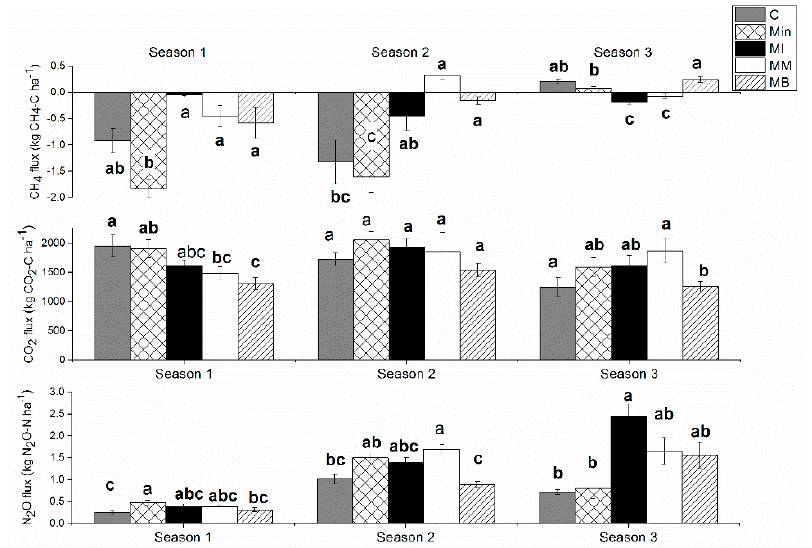
Figure 7. Cumulative CH 4 (CH 4 − C kg ha − 1 ), CO 2 (CO 2 − C kg ha − 1 ), and N 2 O (N 2 O − N kg ha − 1 ) with standard errors fluxes over the three growing seasons sampled from different plots with different fertilizer and manure/irrigation treatments. Bars with different letters indicate significant differences among the treatments (Duncan’s test 0.05 significance level) .